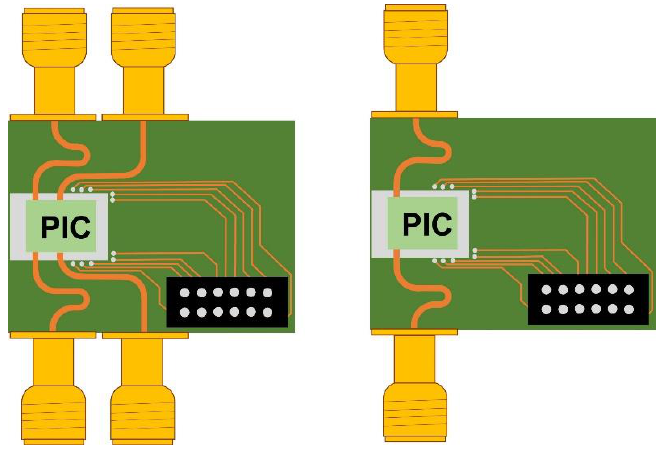
Figure 7. On the black port, there will be DC signals. The electrical waveguides for the RF signals should have the same length on the respective MZM; otherwise, phase will need to be adjusted. ( Left ) Packaging of the DE-MZM FS. ( Right ) Packaging of the SE-MZM FS. In this representation, we are not including the RF ports for the EOPM used for comb generation.